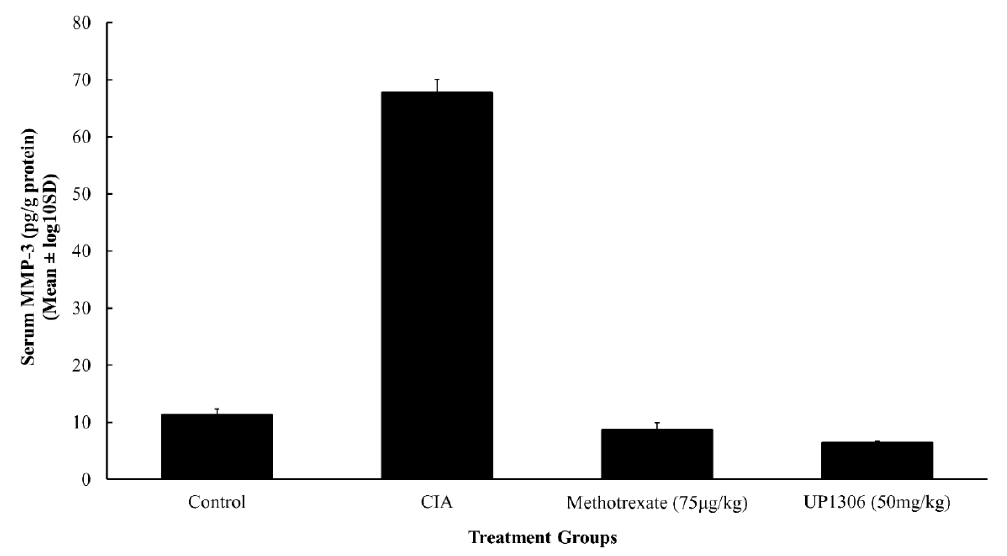
Figure 9. Synovial MMP-3 level from CIA rats. Rats ( n = 10/group) were orally treated with UP1306